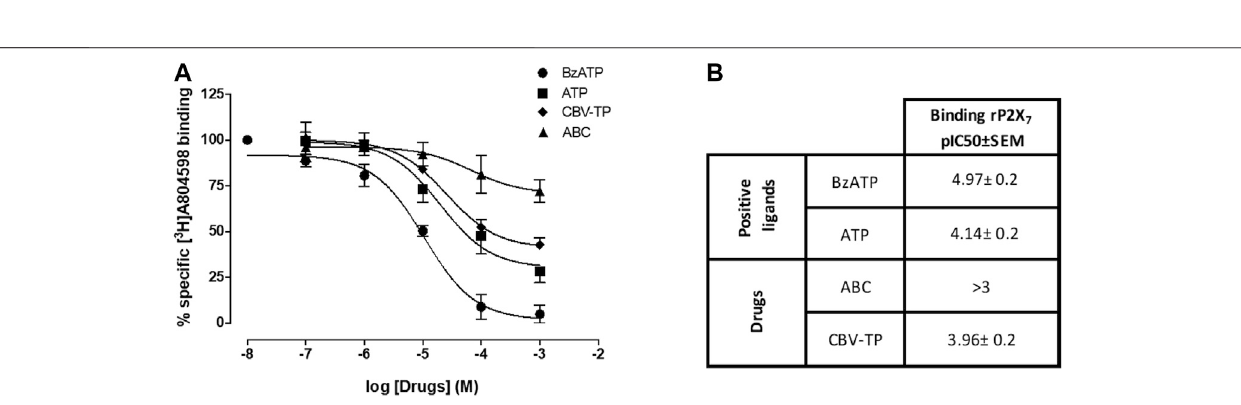
FIGURE 6 | Studies of radioligand-binding to P2X7R. (A) Displacement of [3H]A-804598 (P2X7 receptor antagonist, 2.5 nmol/L) by increasing the concentrations of Bz-ATP, ATP, CBV-TP and ABC (0.1 µmol/L-1 mmol/L) at membrane preparations of HUVEC. Results are mean ± SEM, Bz-ATP: n ≥ 3, ATP: n ≥ 6, CBV-TP: n ≥ 6, ABC: n ≥ 5; each experiment was performed in duplicate. (B) Af fi nities (pIC50 values) of Bz-ATP, ATP, ABC and CBV-TP for the human P2X7R.